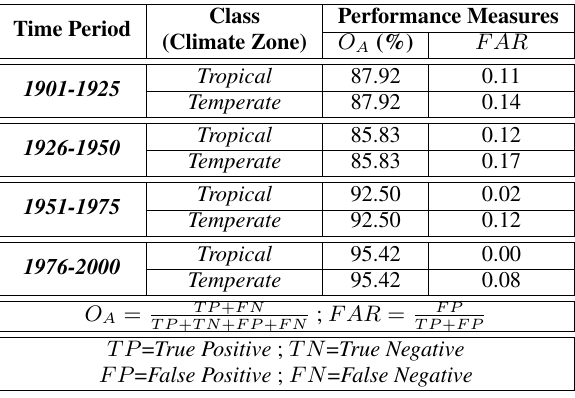
Table 1. External evaluation of climate zone